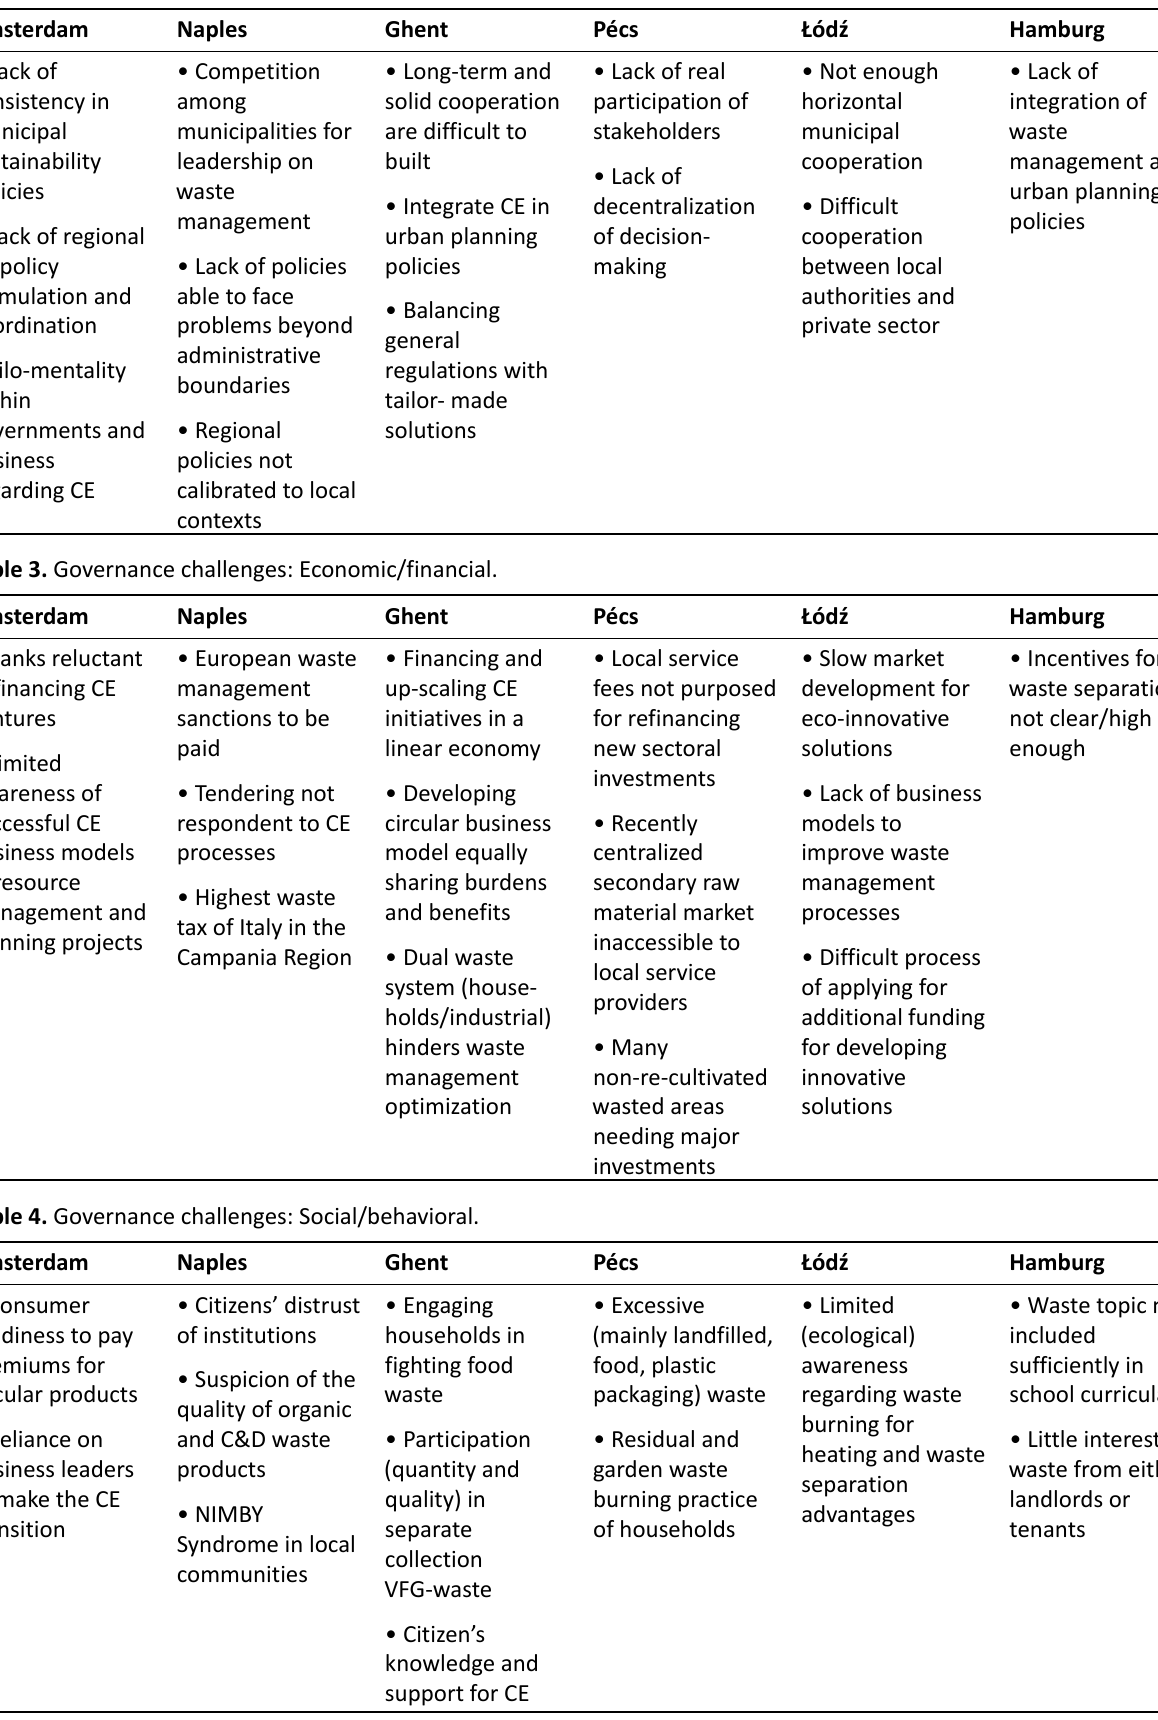
Table 2. Governance challenges: Policy/politics.